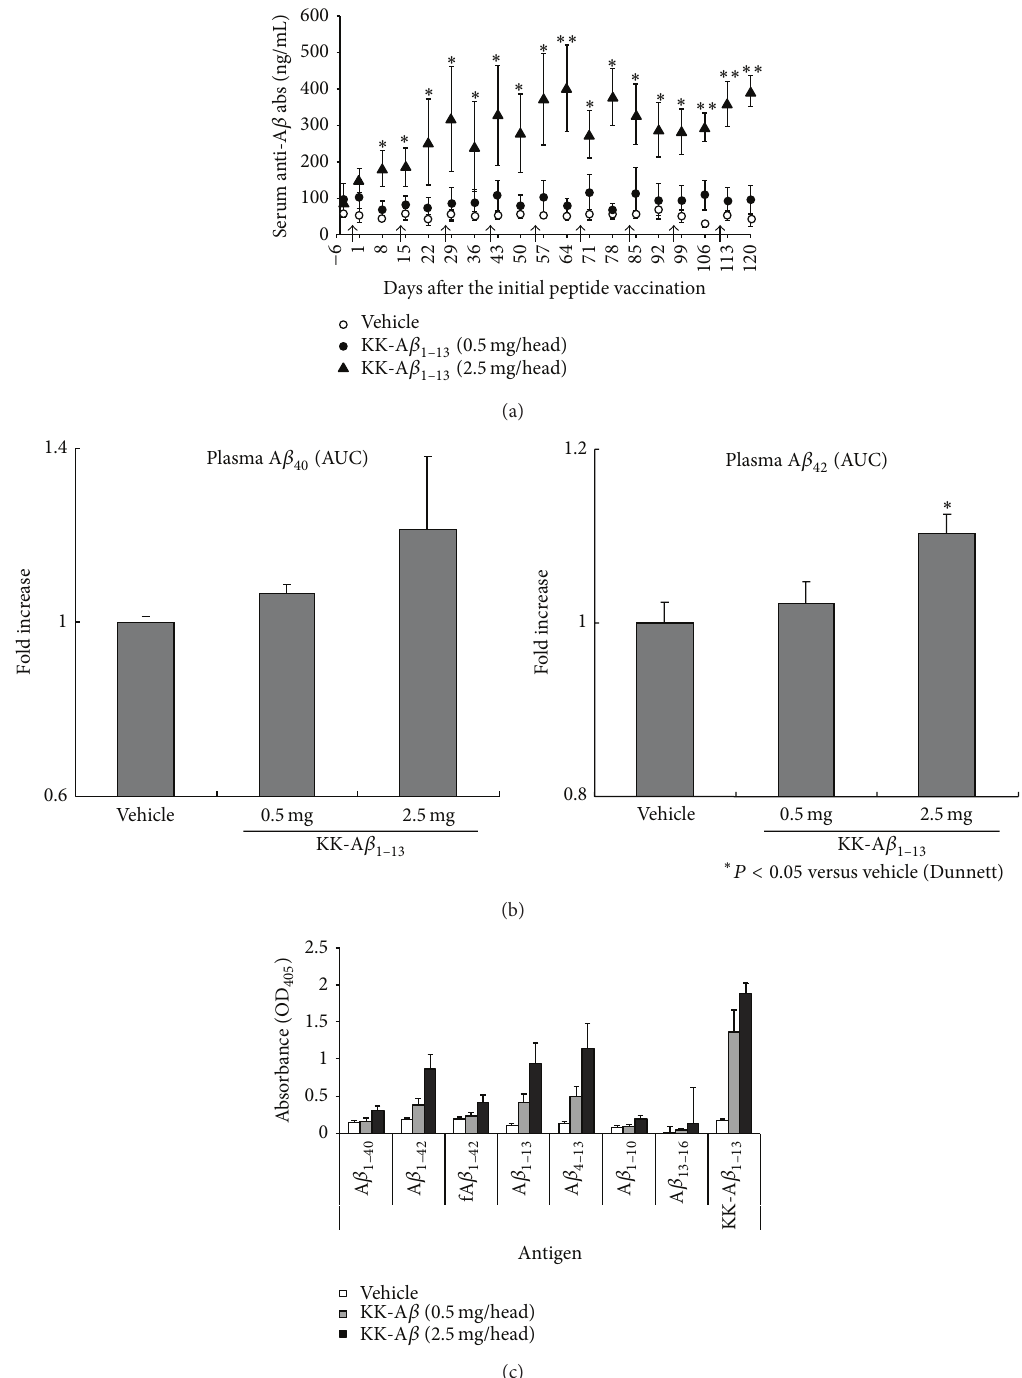
Figure 1: Induction of the anti-A 𝛽 antibodies and A 𝛽 peptides in the peripheral blood by immunization of the peptide vaccine to cynomolgus (a). The plasma monkeys. The serum anti-A 𝛽 antibody levels of the cynomolgus monkeys treated with vehicle or RGD-DiTox 20 -KK-A 𝛽 1 – 13 A 𝛽 40 and A 𝛽 42 peptide (b) level (nM) of cynomolgus monkeys. Diphtheria and tetanus toxoids (DT, 0.5 mL/head, s.c.) were administered to cynomolgus monkeys. Three weeks after the DT treatment, vehicle or the peptide (0.5 or 2.5 mg/head, s.c.) was administered at intervals of 2 weeks (arrows; total 9 times). Blood sampling was performed every week after the initial treatment. Results are represented as mean ± SE ( 𝑛 = 5 ). ∗ 𝑃 < 0.05 and ∗∗ 𝑃 < 0.01 as compared with the vehicle control group (the Dunnett test). Epitope-mapping of plasma anti- -KK-A 𝛽 1 peptide (c). Epitope-mapping of antibodies was performed using A 𝛽 antibodies immunized with vehicle or RGD-DiTox 382 – 401 – 13 each peptide-precoated ELISA with plasma collected at two weeks after the final treatment. Results are represented as mean ± SE ( 𝑛 = 5 ). : RGD-DiTox 20 -KK-A 𝛽 1 KK-A 𝛽 1 – 13 – 13